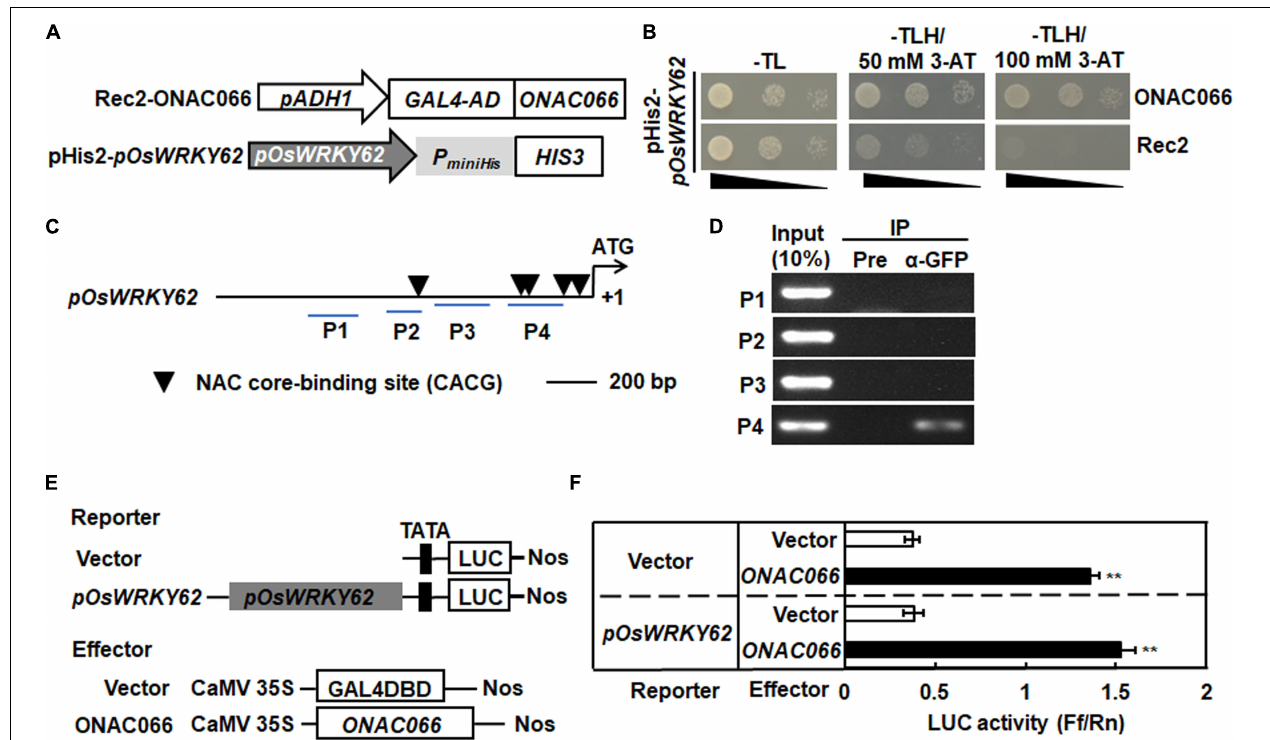
FIGURE 4 | ONAC066 activates OsWRKY62 promoter. (A) Diagram of yeast expression construct Rec2- ONAC066 and reporter construct pHis2- pWRKY62 . (B) Growth performance of transformants on SD/-Leu-/Trp/-His medium containing 50 or 100 mM 3-AT. (C) Diagram of putative NAC core-binding sites in OsWRKY62 promoter. P1-P4 were the probes used in ChIP-PCR assays. (D) ChIP-PCR analysis of ONAC066 binding to OsWRKY62 promoter. ChIP of ONAC066-GFP transgenic line using GFP antibody ( α -GFP) or pre-immune (Pre) serum was performed and precipitated DNA fragments were subject to PCR analysis using OsWRKY62 promoter primers. 10% of chromatin amount before IP was used as positive controls (input) and IP sample with pre-immune serum was used as a negative control. (E,F) Activation of OsWRKY62 promoter by ONAC066. (E) Diagrams of the effector and reporter constructs. A 1500 bp from start codon was used as the OsWRKY62 promoter. (F) Luciferase activity in protoplasts co-transfected with the reporter and different combinations of effectors was determined. Experiments were repeated at least three times with similar results, and results from one representative experiment are shown in panels (B,D) . Data presented in panel (F) are the means ± SD from three independent experiments and ** indicated significant difference at p < 0.01 by Student’s t -test, in comparison to empty vector.